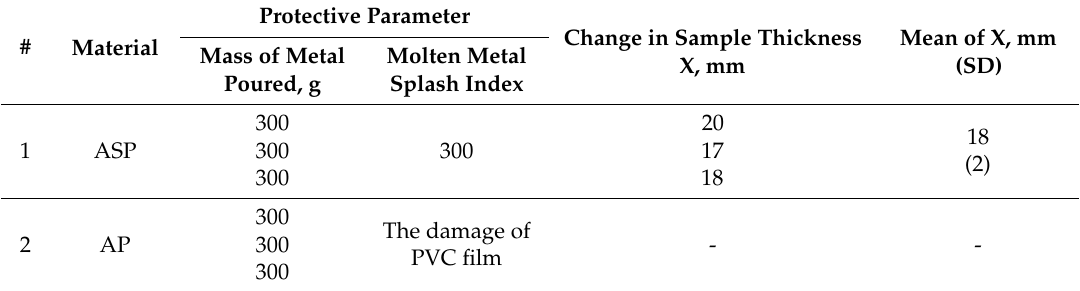
Table 8. Test results of resistance to molten iron splash according to the modified test method: the angle of iron outpour onto the sample was 60 ◦ and the time of metal outpour onto the sample was 7.5